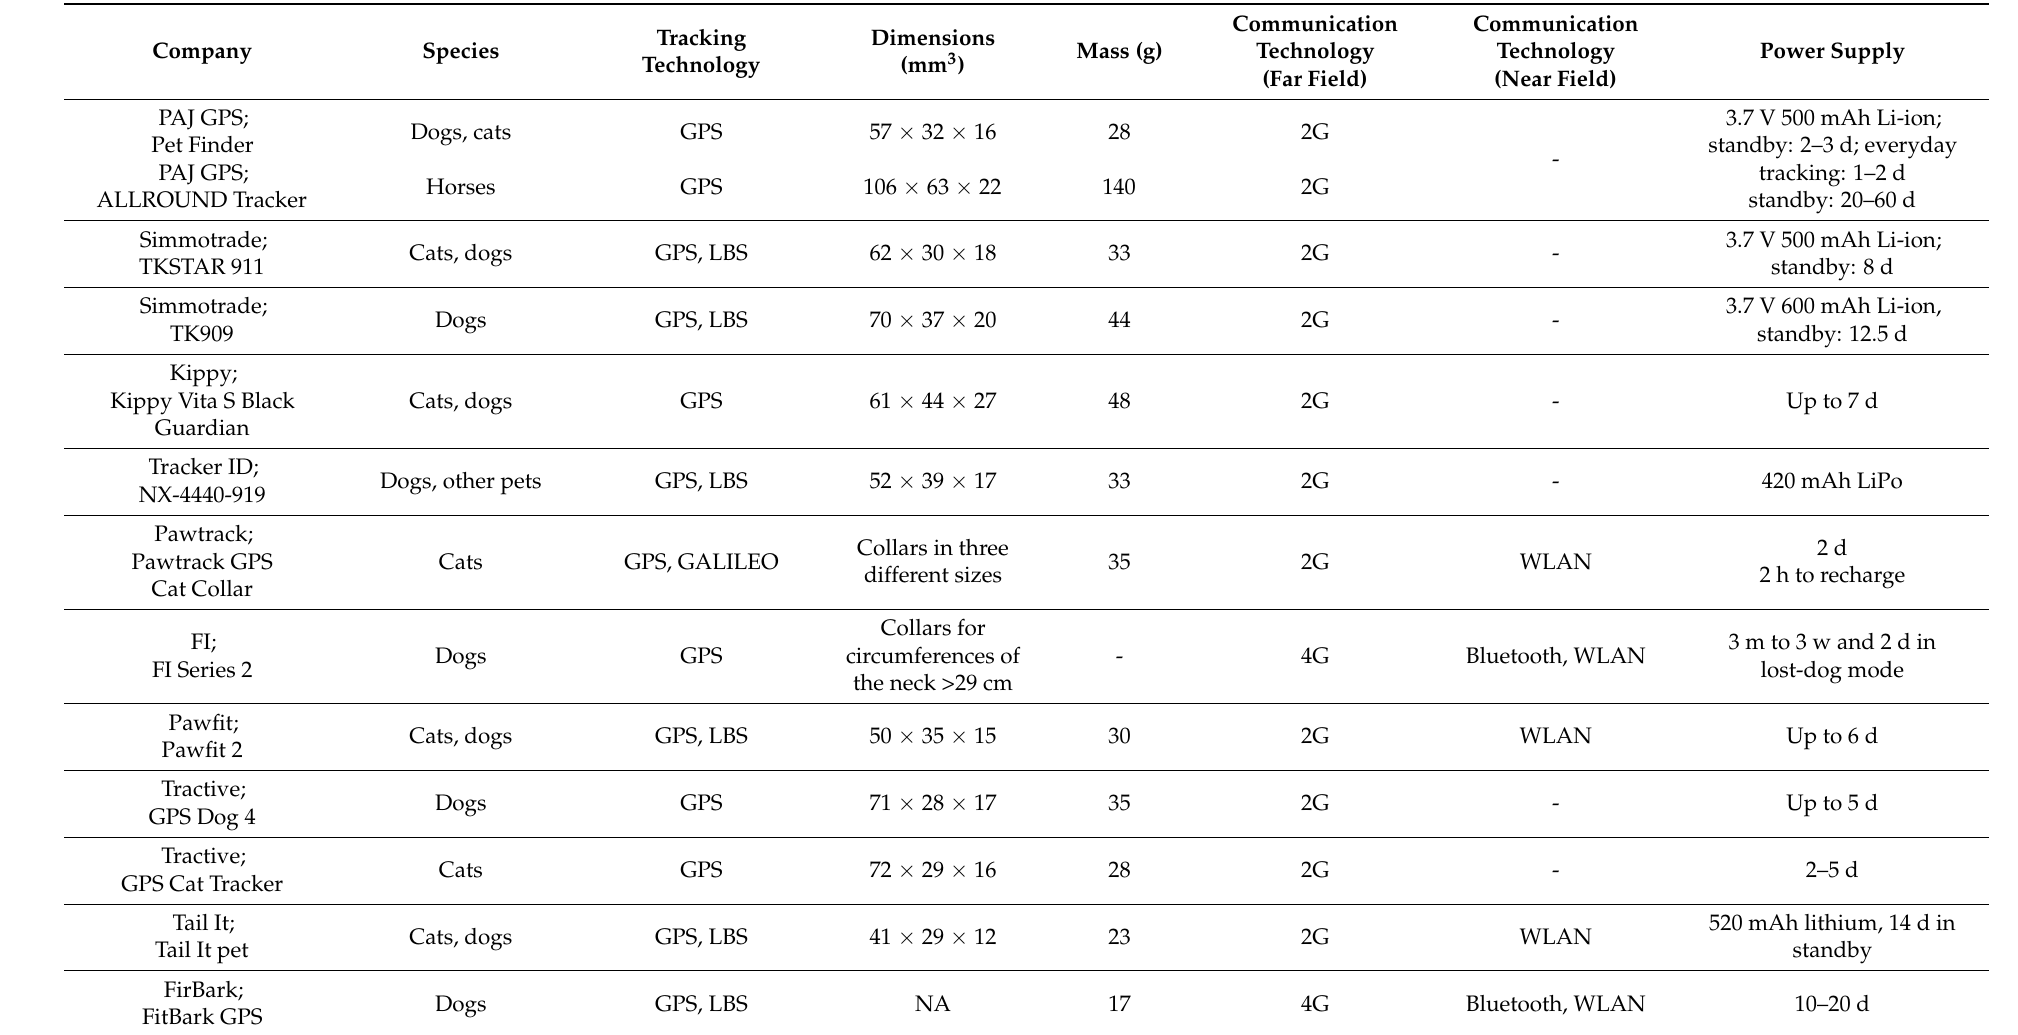
Table 1. Technical features of the investigated tracking